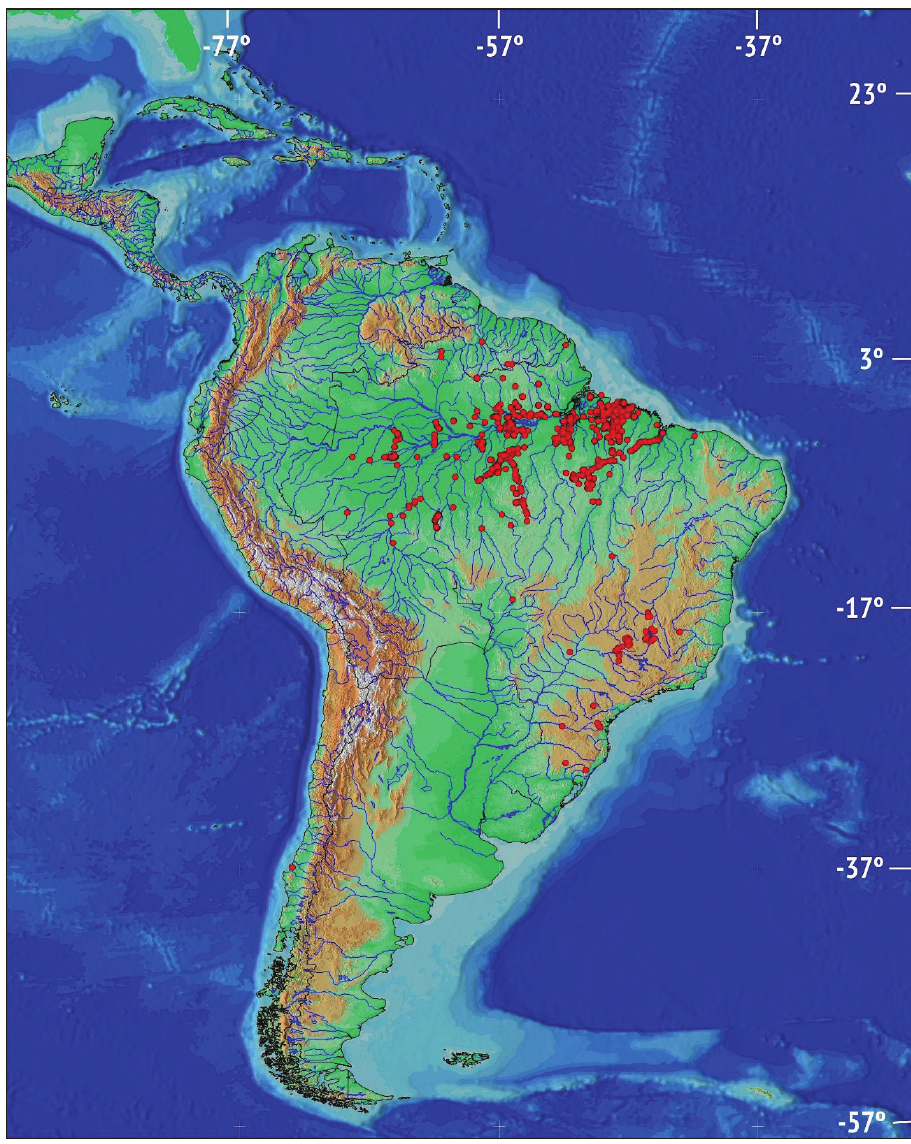
Figure 2. Map of South America showing the localities of all fish specimens with coordinates (dataset available at http://www.gbif.org/dataset/b0059a3a-5cab-4a08-8d14-d92c23378e43) . Some dots represent more than one